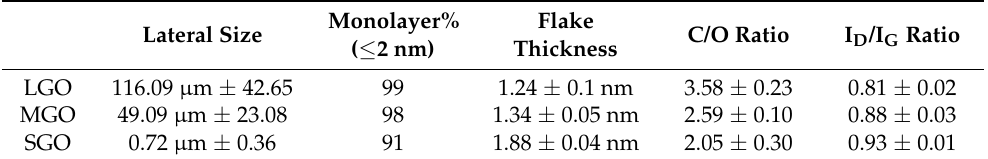
Table 1. Properties of three different GO samples. Error bars represent standard error of mean (SEM), n =